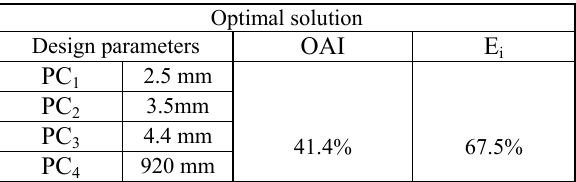
Tableau 7. The accuracy and environmental impact indicators of the optimal solution Optimal